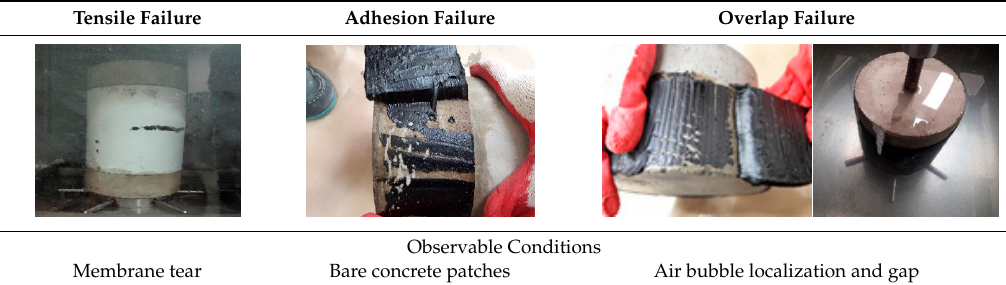
Figure 7. Waterproofing membrane evaluation after testing ( a ) leakage detection; ( b ) incision to separate mortar slabs; ( c ) checking interior surface; ( d ) analysis. Table 11. Identification of failure types for leaked specimens.